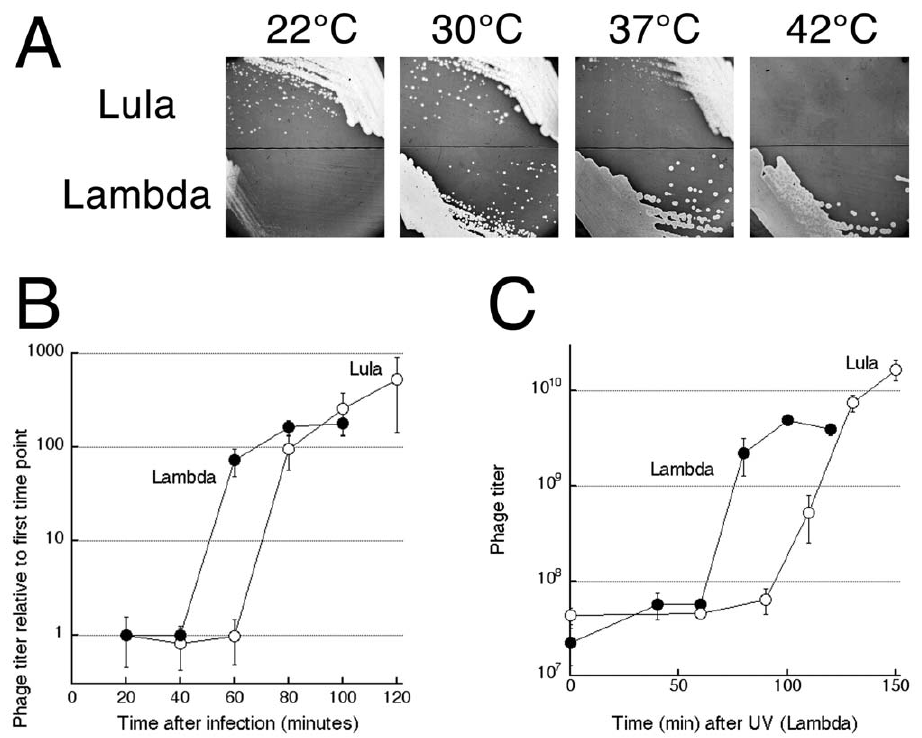
Figure 3. Lula shows an inverted temperature gradient compared to Lambda. A. The optimal temperatures for lytic growth of Lula versus Lambda. The corresponding phages from high titer lysates were streaked on a freshly-poured lawn of susceptible bacteria (AB1157). B. One-step growth at 37 u C on AB1157. The data points are means of 3–5 independent measurements, done on different days, 6 SEM. C. UV-induction of lytic development from a lysogen at 37 u C. Lula lysogen, EL103; Lambda lysogen, EL104. The data points are means of three (for Lambda) or four (for Lula) independent measurements, done on different days, 6 SEM.